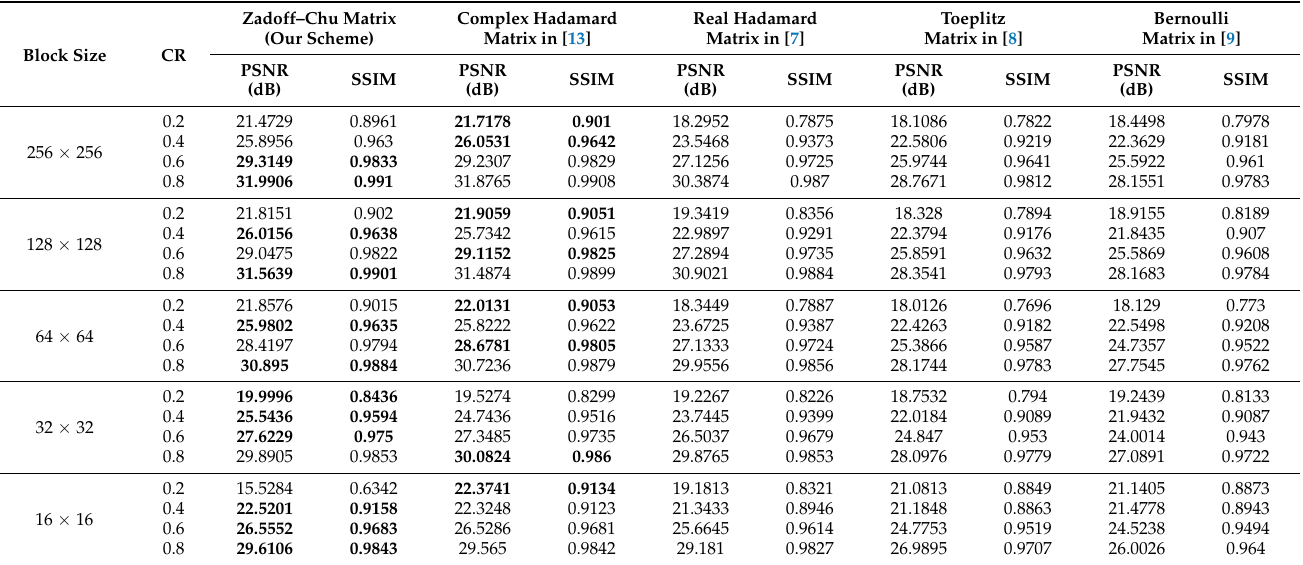
Table 2. Comparison of reconstruction performance between different measurement matrices for “Lena” image based on OMP reconstruction algorithm. The bold indicates the best PSNR value and SSIM value of each